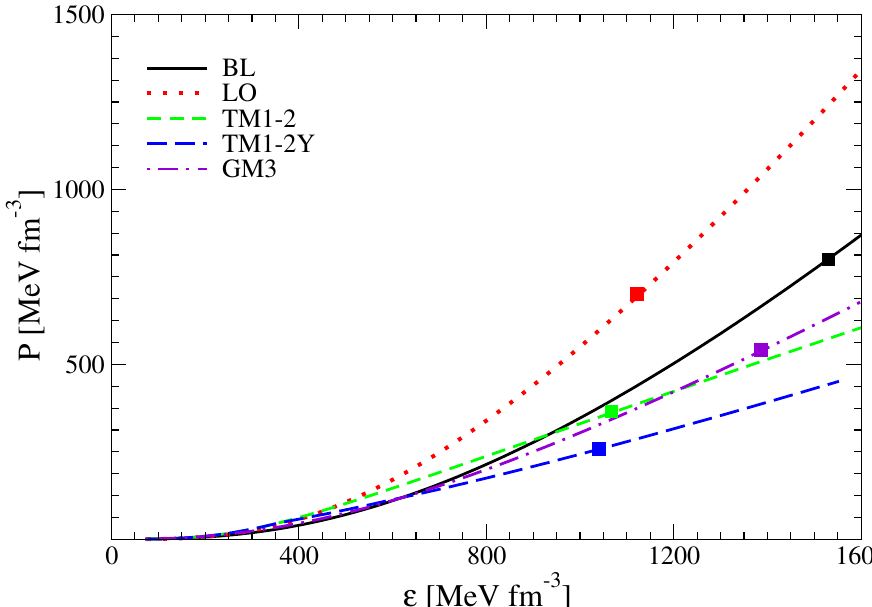
Figure 1. Equation of state for the models described in the text. P denotes the total (i.e., including the leptonic contribution) pressure and ε the total energy density for β -stable matter. The square on each curve marks the value of the central energy density ( ε c ) of the neutron star maximum mass configuration for the corresponding EOS model (see fifth column in Table 1).